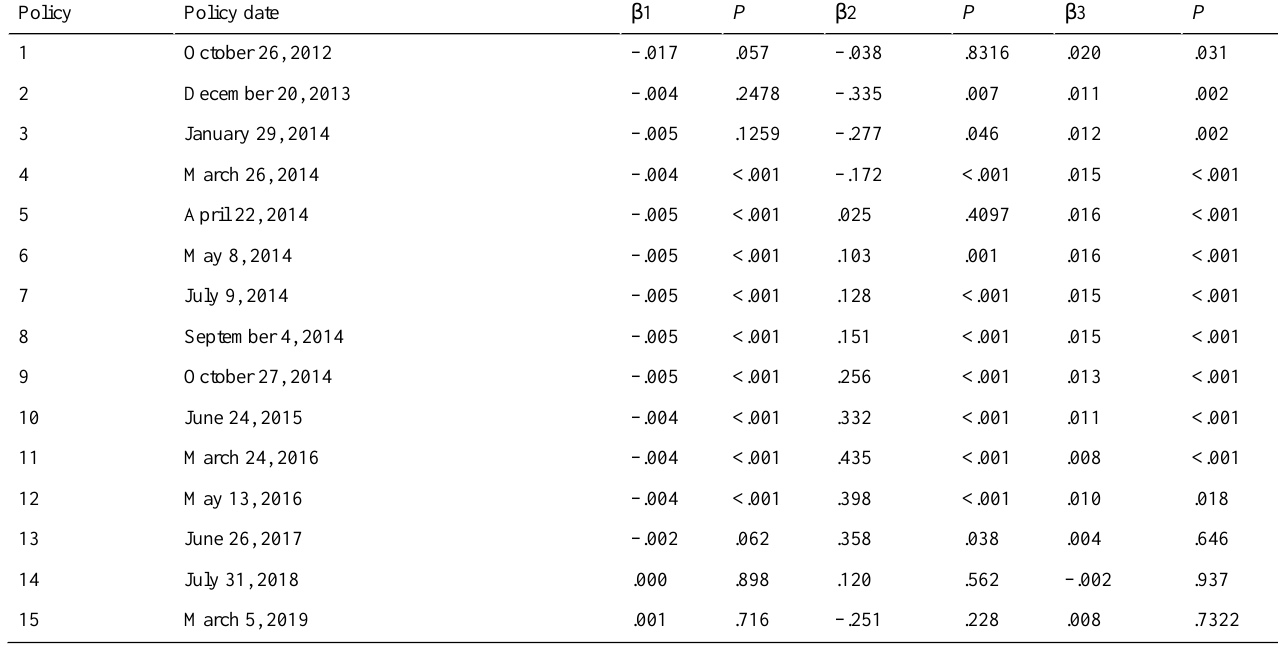
Table 8. Blame doctor regression parameters at 15 policy time